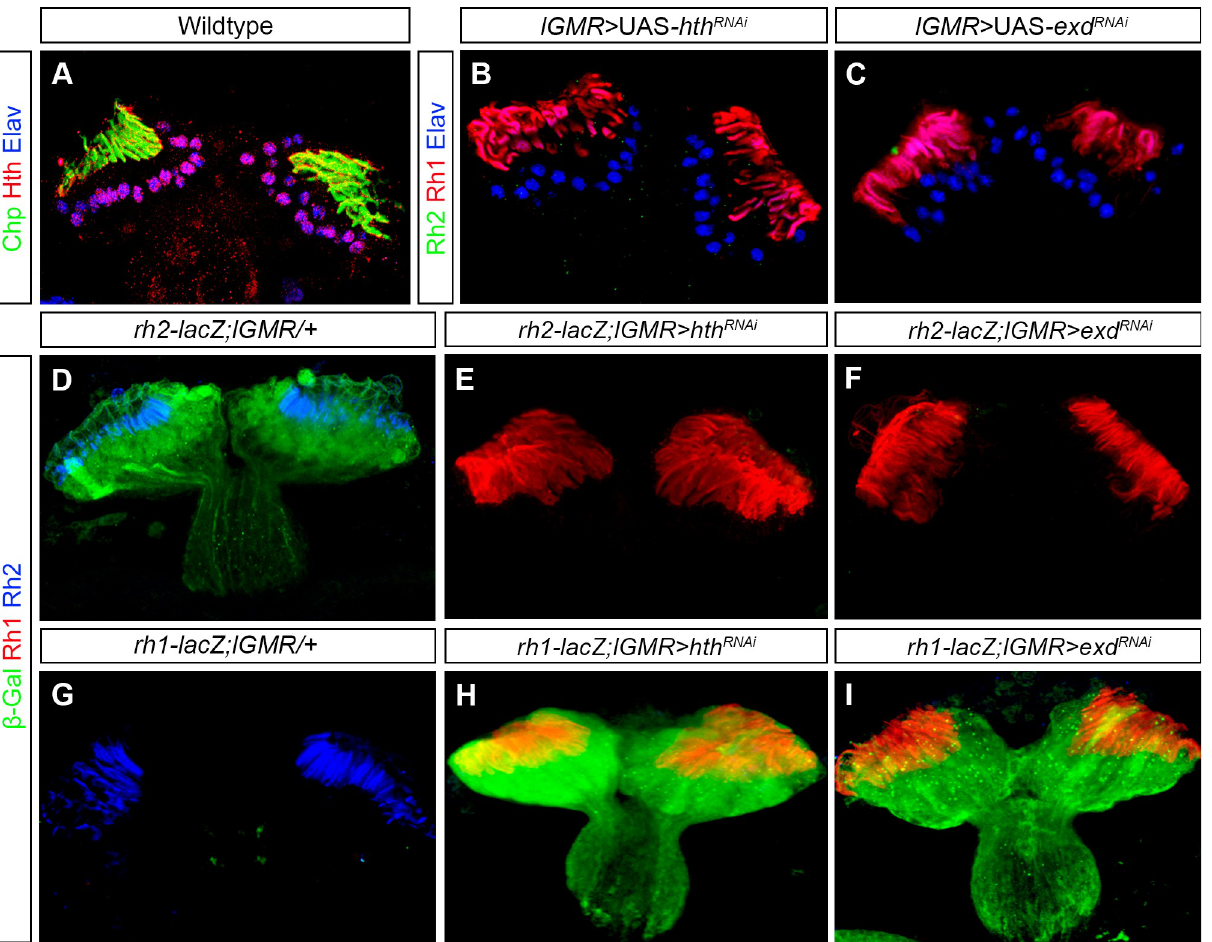
Fig 2. Hth expression and phenotype in ocelli. (A) Antibody staining of Hth in the wildtype ocelli showing its expression in all ocellar PRs. Chp (green) and Elav (blue) marks ocellar PR neurons. (B) hth knockdown ( lGMR > UAS- hth RNAi ) in the ocelli by pan-photoreceptor lGMR -Gal4. In hth knockdown, Rh2 expression (green) is lost and there was a gain of Rh1 expression (red) in the ocellar PRs. (C) exd knockdown ( lGMR > UAS- exd RNAi ) in ocelli showed a similar phenotype i.e., loss of Rh2 expression (green) and gain of Rh1 expression (red). (D, E, F) Antibody staining of β -Galactosidase ( β -Gal) in the control ( rh2-lacZ; lGMR/+ ), in hth knockdown ( rh2-lacZ; lGMR > hth RNAi ) and in exd knockdown ocelli. β Gal (green) expression was seen in control ocelli, also marked by Rh2 (blue) (D). However, β Gal (green) expression was absent in both hth and exd knockdown ocelli, and ocellar PRs in both knockdowns were marked by Rh1 (red) (E, F). (G, H, I) Antibody staining of β Gal in the control ( rh1-lacZ; lGMR/+ ), in hth knockdown ( rh1-lacZ; lGMR > hth RNAi ) and in exd knockdown ocelli. In the control, ocelli were marked by Rh2 (blue) and β Gal (green) expression was absent (G) whereas β Gal expression was seen ectopically in both hth and exd knockdown ocelli where ocellar PRs were marked by Rh1 (red) (H,